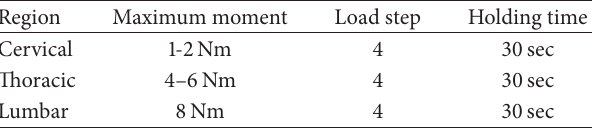
Table 1: Test conditions for measuring property